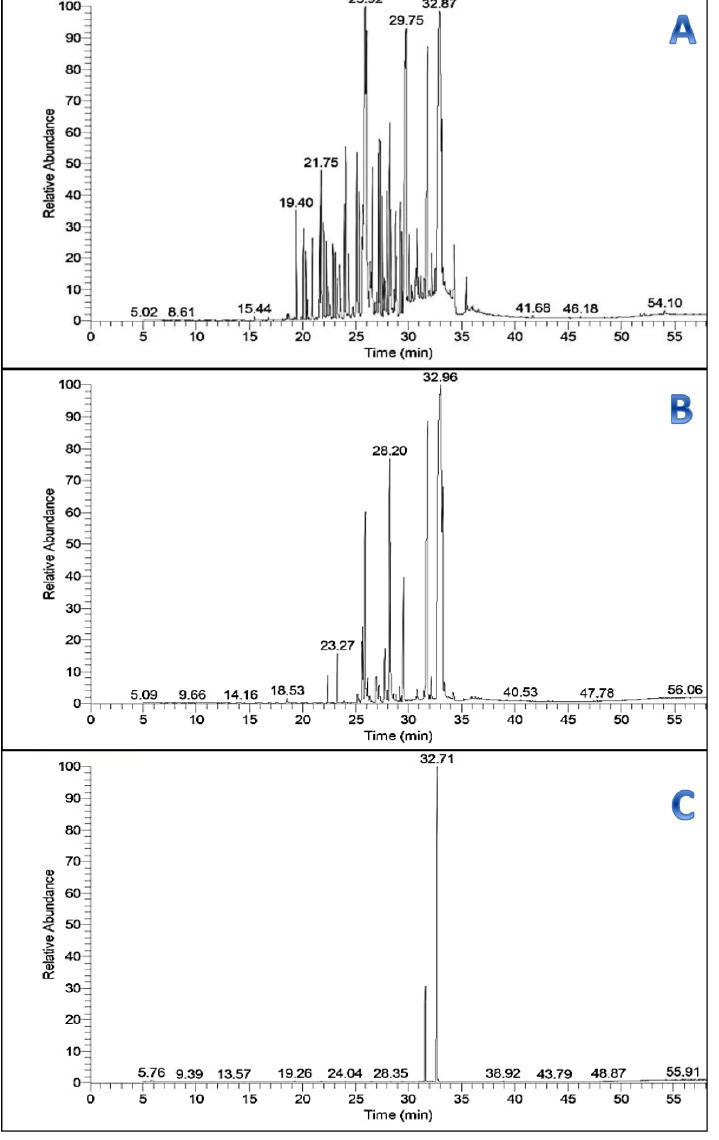
Figure 3. GC/MS chromatograms of ( A ) the crude n -hexane extract of S . costus ; ( B ) PuriFlash 4100 system all bold fractions; and ( C ) active fraction (individually).